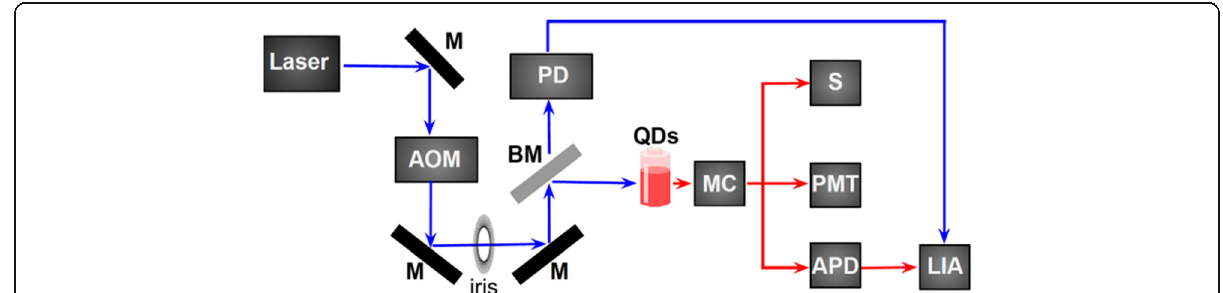
Fig. 7 Diagram of the experimental setup. M mirror, AOM acousto-optic modulator, BM beamsplitter, PD photodiode, MC monochromator, S spectrometer, PMT photomultiplier tube, APD avalanche photodiode, LIA lock-in